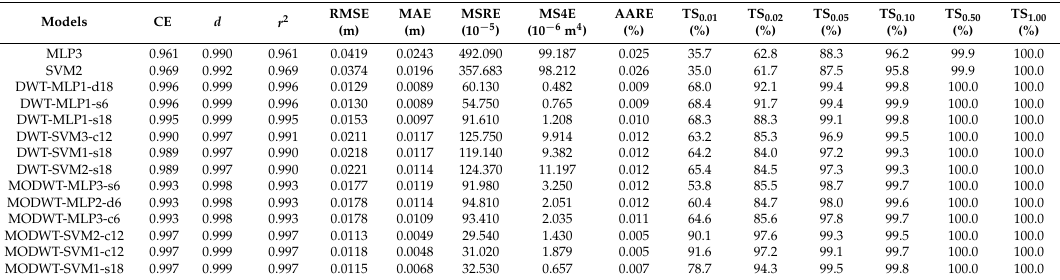
Table 2. Comparison of higher performance models for the overall